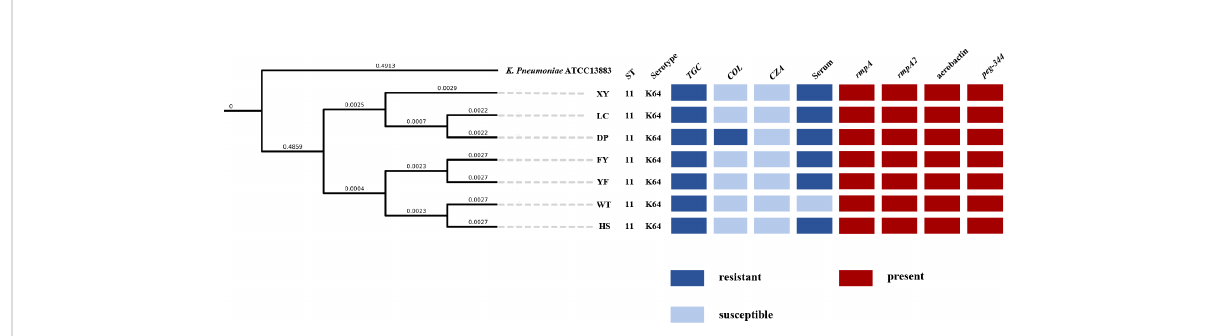
FIGURE 3 Phylogenetic tree of seven XDR-hvkp and K. pneumoniae ATCC 13883 based on OrthoANI values; K. pneumoniae ATCC 13883 was used as a control. The value on the branch, not the length of the branch in the graph, represents the real physical length of the